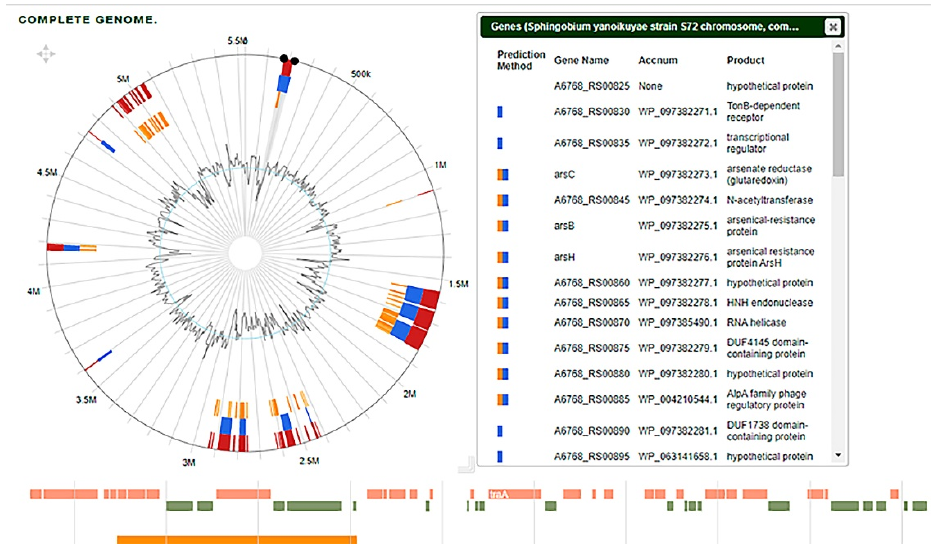
Figure 4. Genomic island predicted in S72 with Island viewer 4.